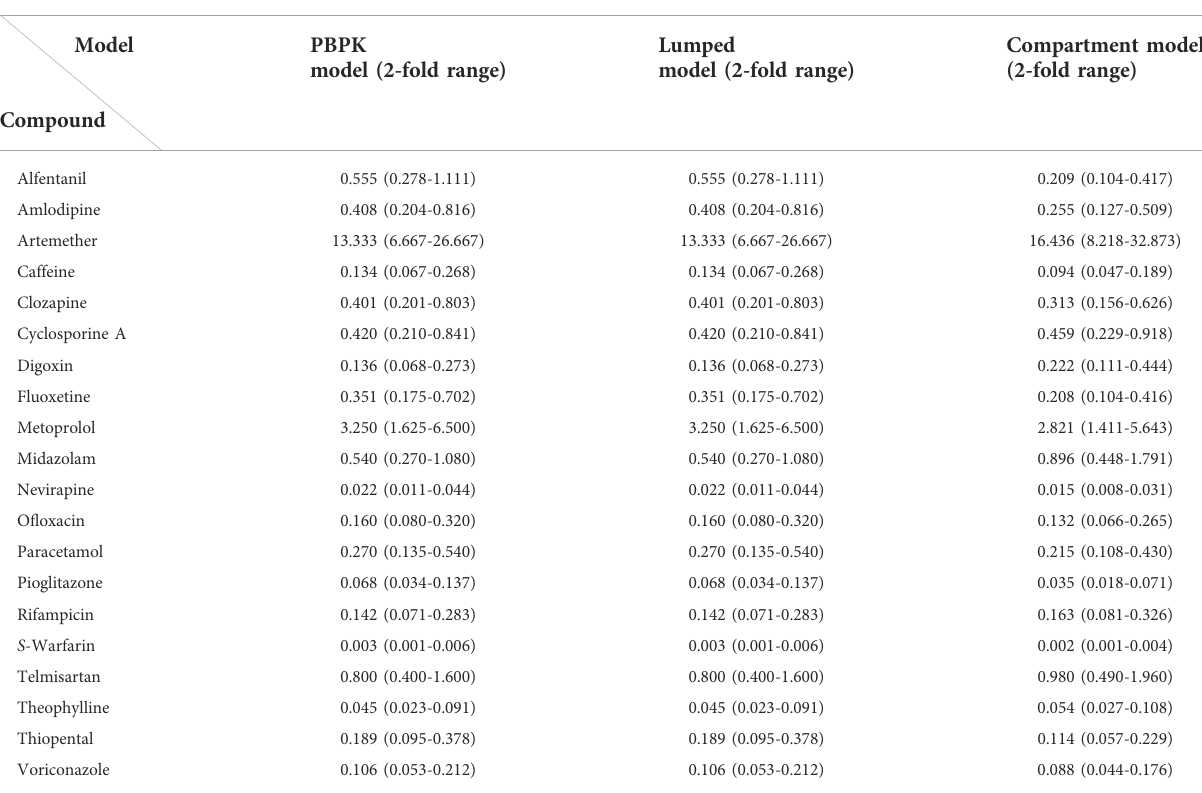
TABLE 3 Comparison of CL parameters in PBPK, lumped, and compartment models for 20 compounds. Parameter